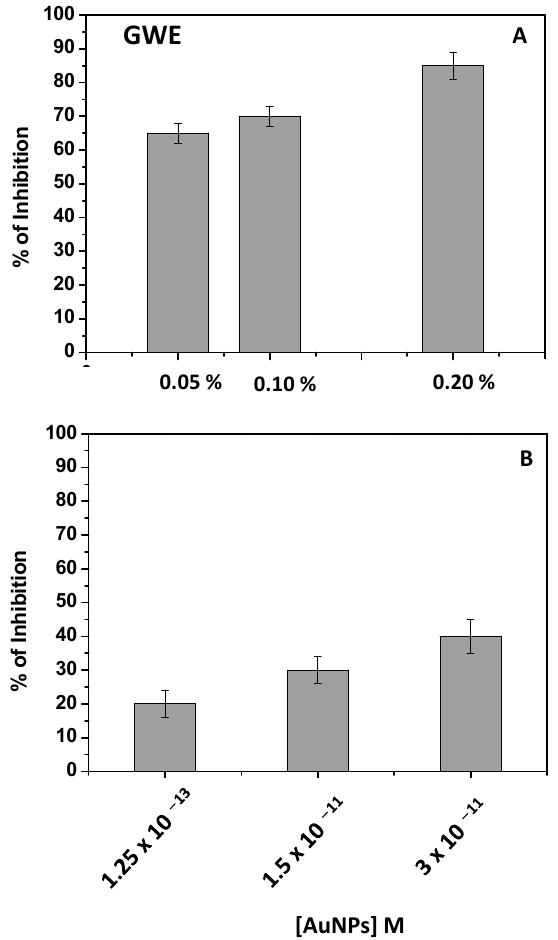
Figure 7. Percent of tyrosinase inhibition of raw GWE (2 mg/L) ( A ) and AuNPs ( B ) at different amounts.